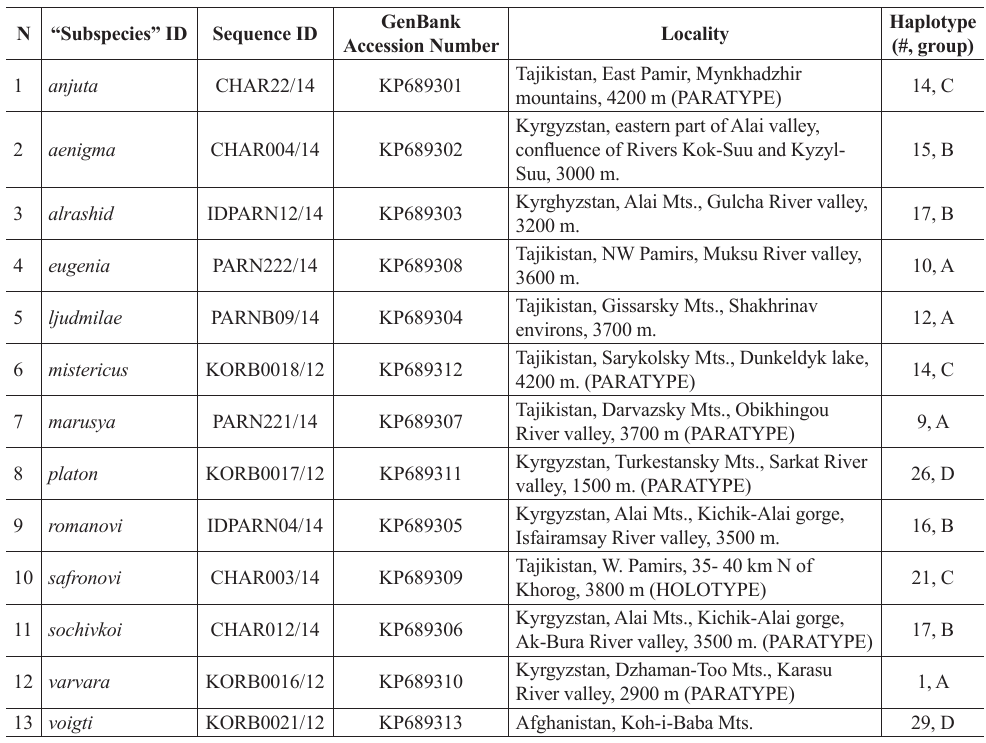
Table 2. Sampled specimens of K. charltonius (see Fig.